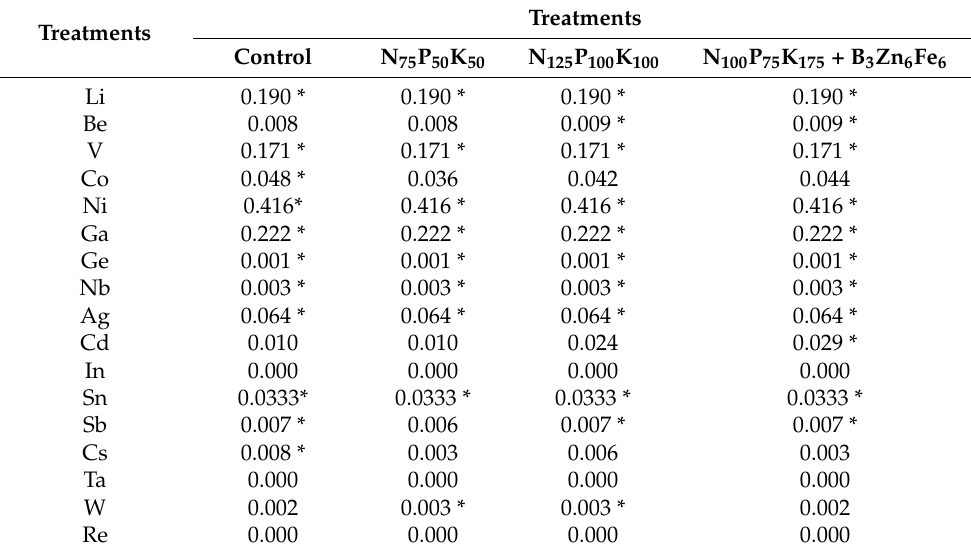
* All the values are the average of three replicates ( n = 3), and the mean with the same letter (superscript) in the columns are not significantly different ( p < 0.05)—(Tukey’s test).